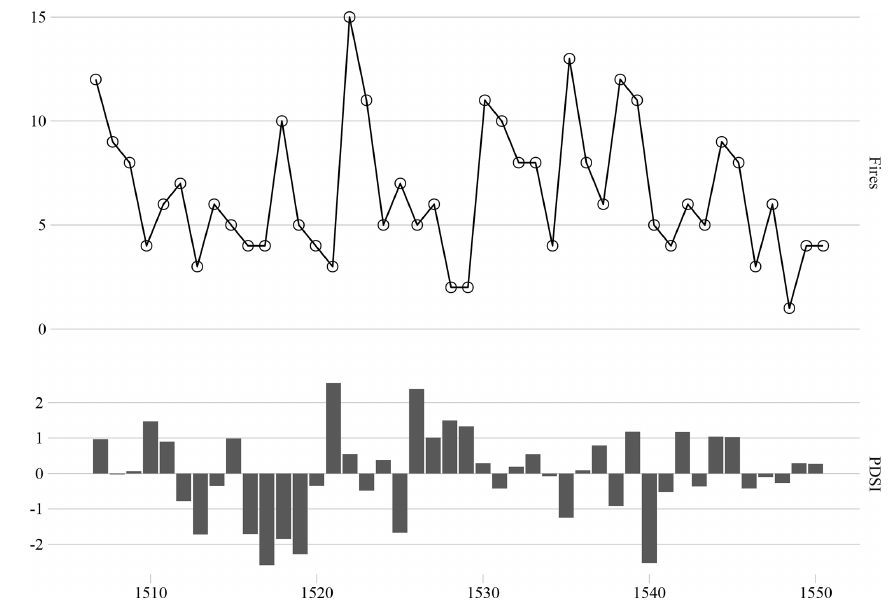
Figure 11. Number of fires and PDSI. Source: Archival sources AS 4 and Cook et al.